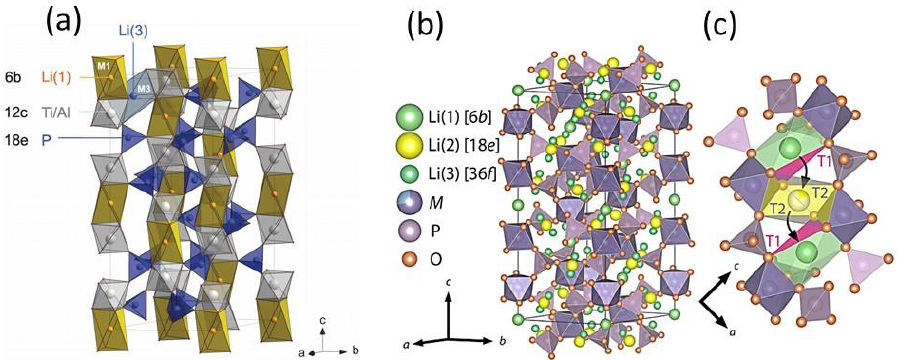
Figure 29. Structure of ( a ) Li 1+ x Al x Ti 2− x (PO 4 ) 3 (LATP) and ( b ) Li 1.5 Al 0.5 Ge 1.5 P 3 O 12 (LAGP). ( c ) The M I and M II intercalation sites correspond to the main occupied and excess ( x ) Li + sites, respectively. Reproduced with permission from [49]. Copyright 2019 Wiley.